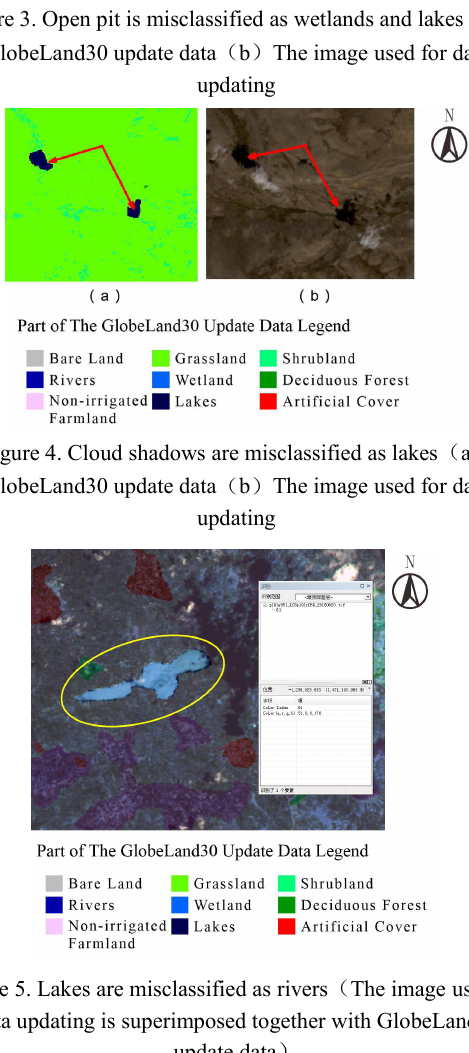
Figure 8. Regions with the same texture on the image are classified into two different classes （ a ） GlobeLand30 update data （ b ） The image used for data updating